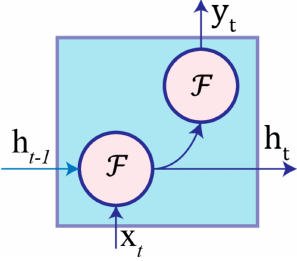
Figure 1. Schematic diagram of an RNN node where h t − 1 is the previous hidden state, x t is the current input sample, h t is the current hidden state, y t is the current output, and (cid:70) is the activation